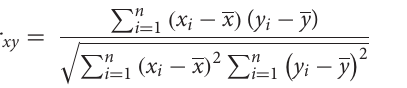
the template, x, and each 300 ms of candidate component at the times of the IED, y, was defined as the magnitude of the sample correlation, | r xy |, presented in Eq.